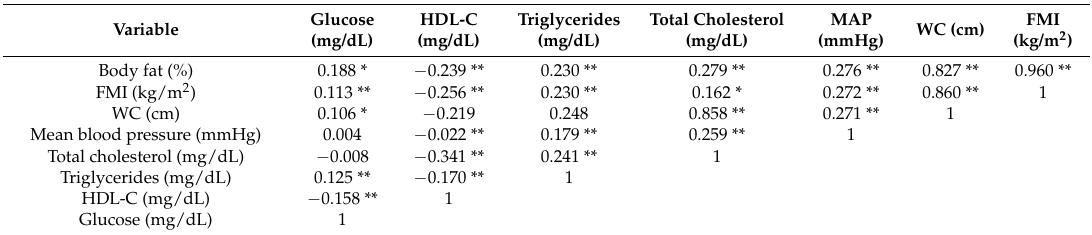
Table 3. Results of the partial correlation analysis between body fat percentage (BF%), fat mass index (FMI), and MetS components.